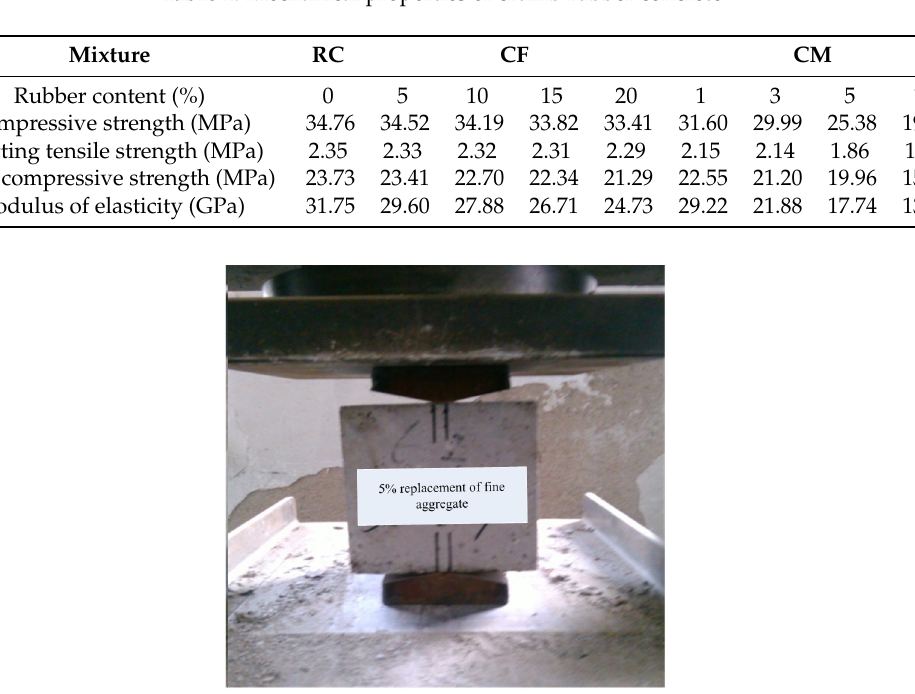
Table 2. Mechanical properties of crumb rubber concrete.